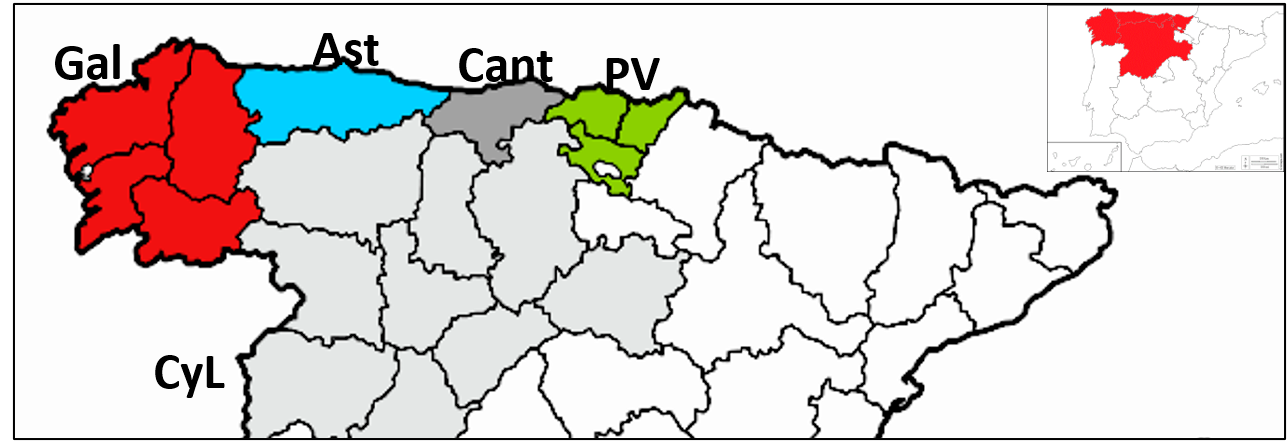
Figure 1. Geographic origin of the Spanish Fusarium circinatum isolates used in this study. Gal: Ga ‐